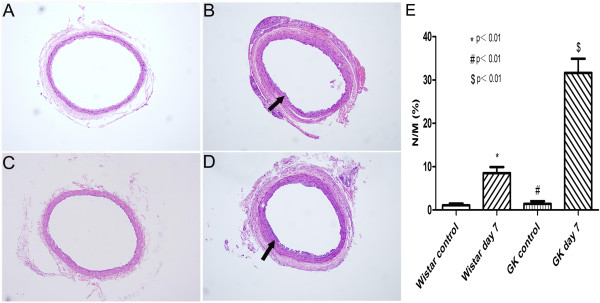
Morphological changes of rat common carotid arteries by H&E staining method (magnification ×200). (A) Wistar rats control. (B) Neointimal formation was seen in Wistar rats at day 7 after balloon injury. (C) GK rats control. (D) Visible neointimal formation was observed in GK rats at day 7 after balloon injury. (E) The degree of neointimal hyperplasia expressed by N/M in Wistar and GK rats after balloon injury increased significantly as compared to Wistar and GK rats control, respectively. N/M in GK rats was significantly higher than in Wistar rats. Arrows in images sign neointimal formation after balloon injury. * indicates Wistar control versus Wistar day 7, # indicates GK control versus GK day 7, $ indicates Wistar day 7 versus GK day 7. p<0.01.